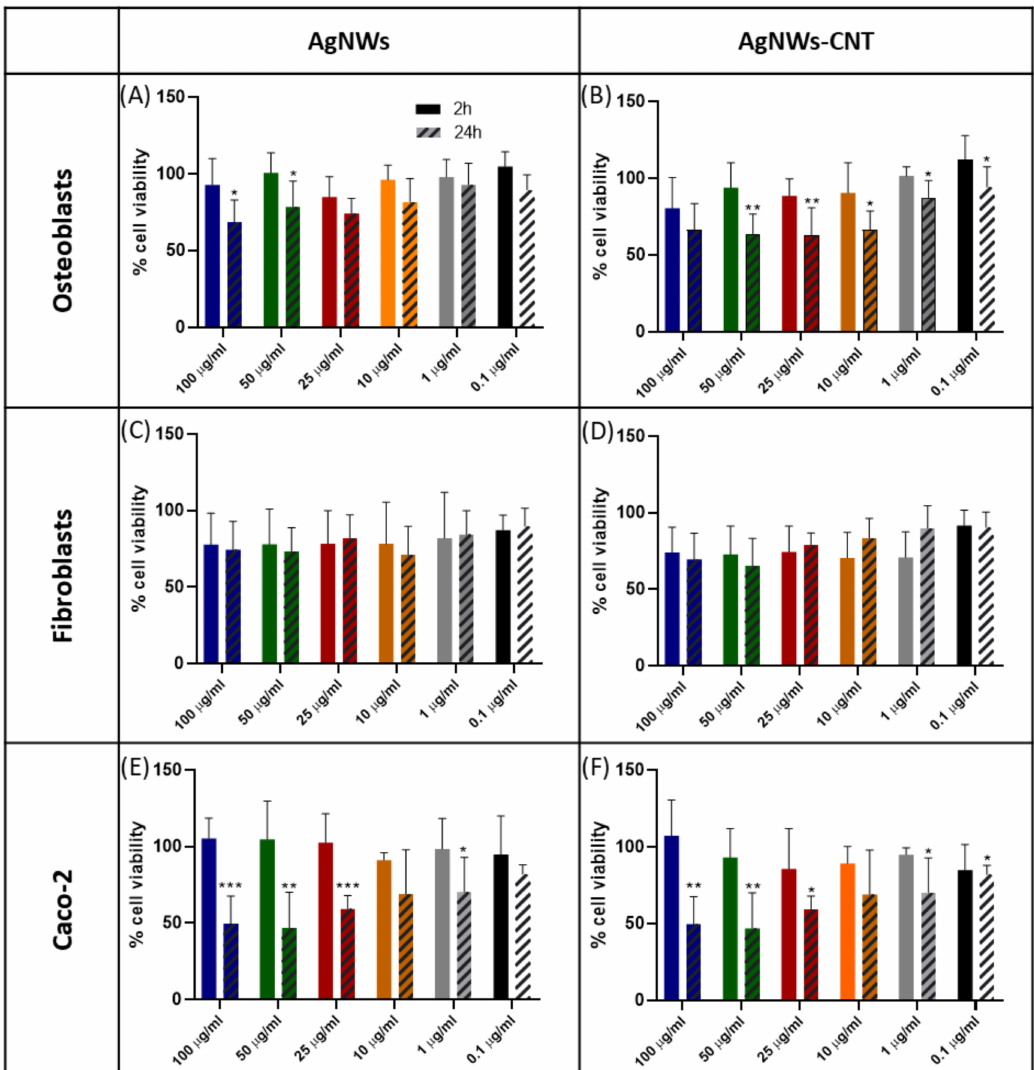
Figure 6. Cytotoxicity observed in di ff erent types of cell lines after 2 and 24 h of treatment. Osteoblasts ( A , B ), fibroblasts ( C , D ), Caco-2 ( E , F ). Data are presented as the mean ± SD ( n > 3). The one-way ANOVA performed on all samples showed significantly di ff erent viability for AgNWs and AgNWs-CNT (* indicates p < 0.05, ** indicates p < 0.01, *** indicates p < 0.001 and **** indicates p <